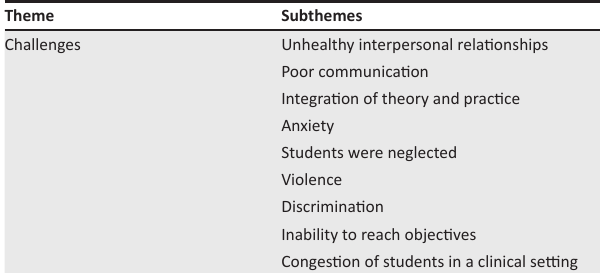
TABLE 1: Themes and